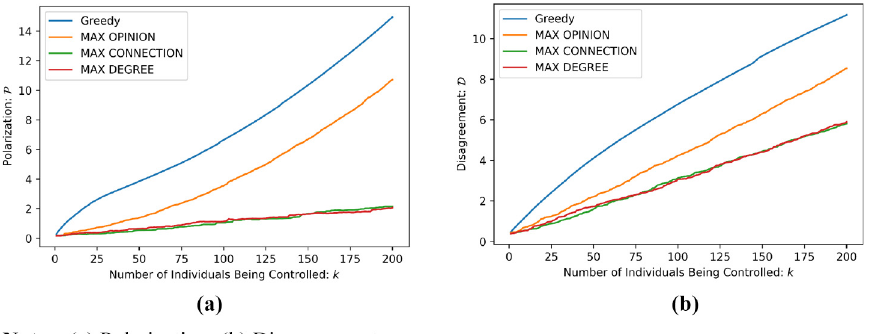
Figure 3. Polarization